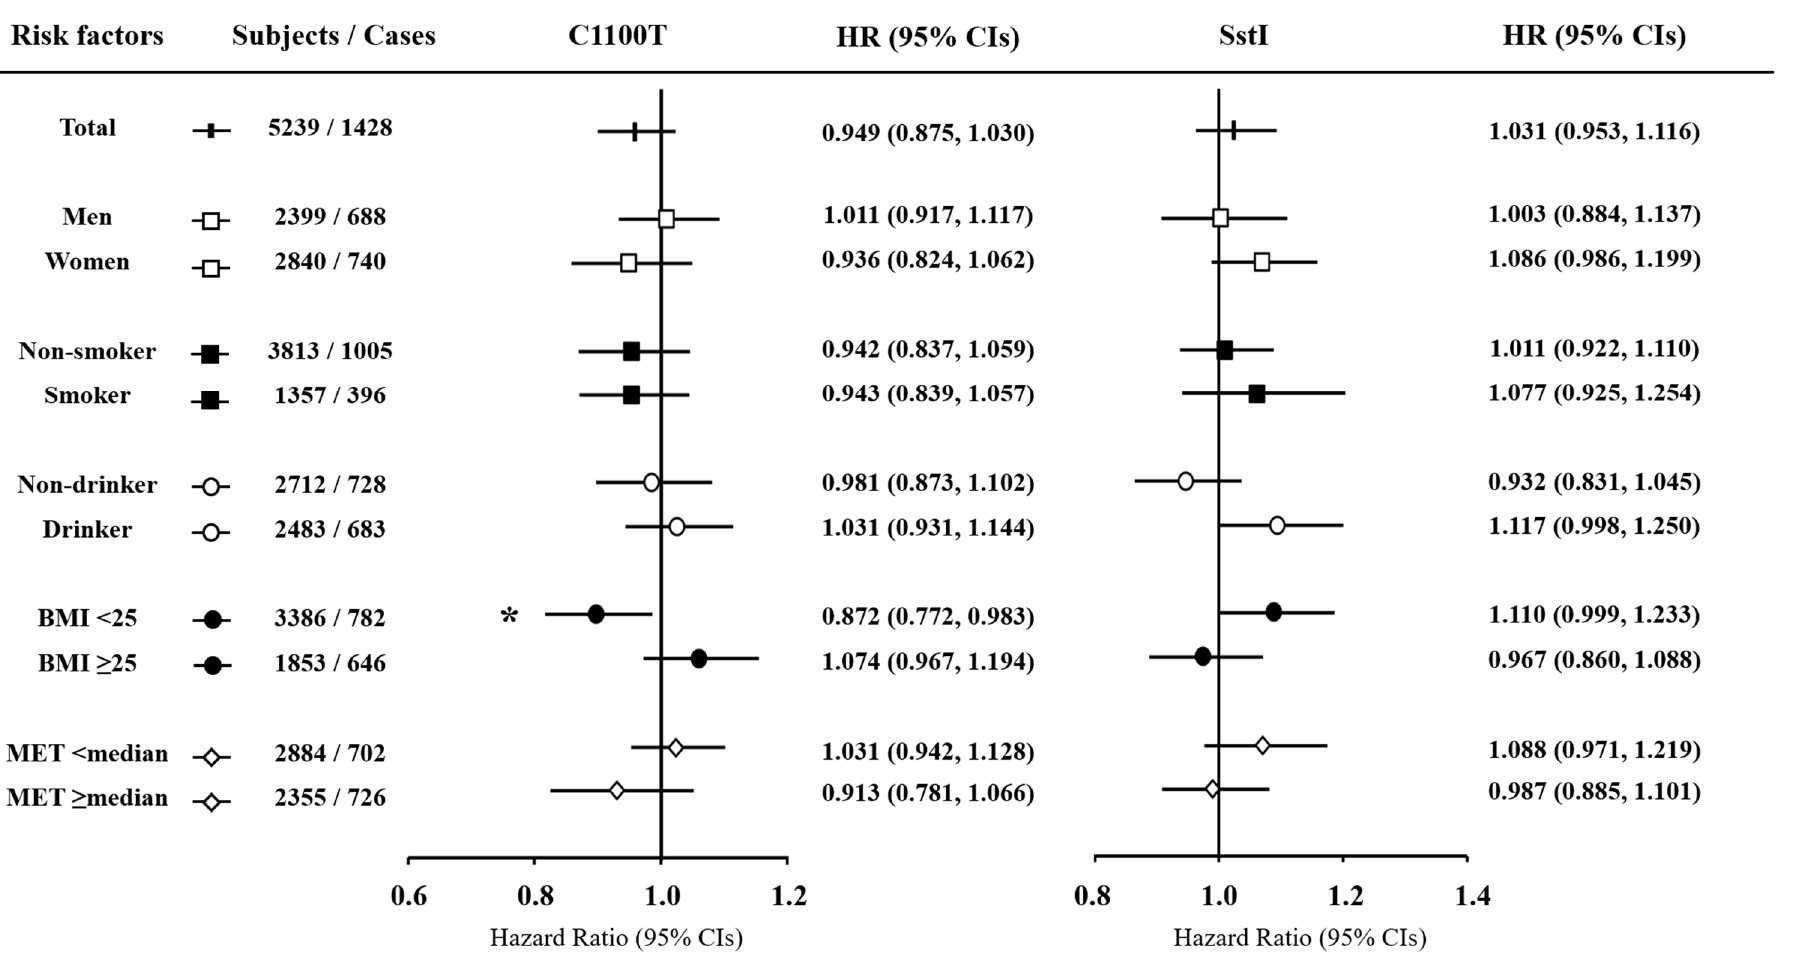
Figure 1. Associations of APOC3 polymorphism with hypertension risk according to candidate lifestyle-related factors. BMI, body mass index; HR, hazard ratio; MET, metabolic equivalent. The median level of MET in the total population is 13.2 (h/day). Tested by Cox regression analyses adjusted for age, gender, area, total energy intake, physical activity, education level, smoking status, alcohol use, and BMI. Some variables included missing values. * Significant p value ( p < 0.05).